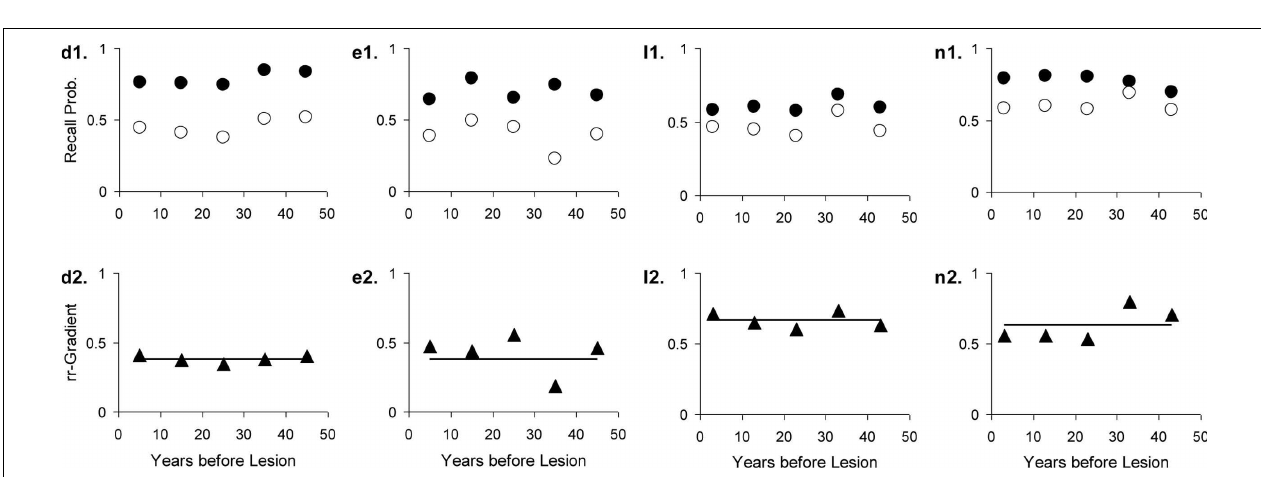
FIGURE 12 | Four studies with Huntington’s Disease patients and matched controls. The letters with each panel correspond to those in Table 3 . See Figure 10 for further